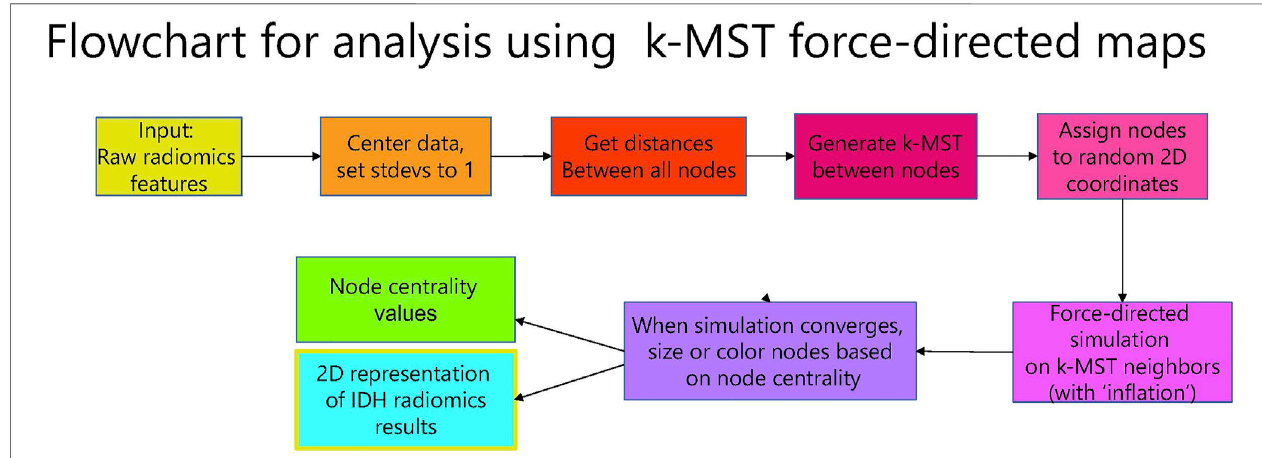
FIGURE 2 | Flowchart for analysis using k-MST force-directed